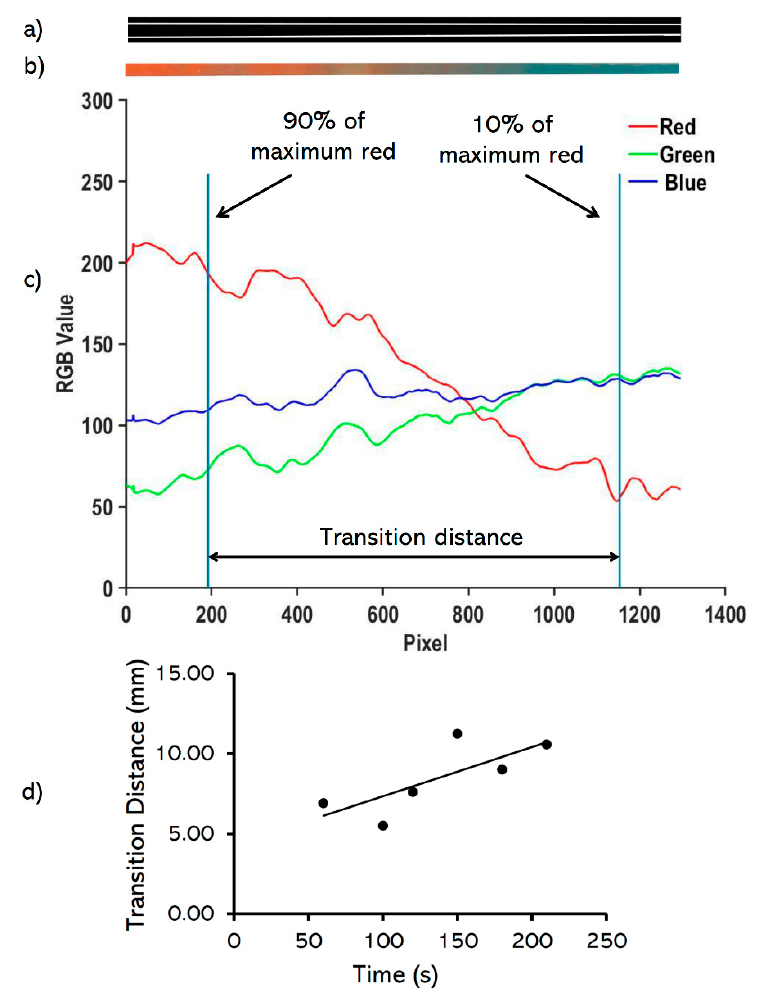
Figure 2. Image analysis of the printed red and blue bioinks. ( a ) converting of the cropped image to black and white to detect the filament edges, ( b ) cropping the transition area of the printed pattern, ( c ) determining the transition distance within 90% of the maximum red value to 10% of the maximum red value while switching from red to blue ( d ) identifying the rate of change in the transition distance ( D tr = 0.03060 × t ), where D tr is the transition distance (in mm) and t is time (in·s).